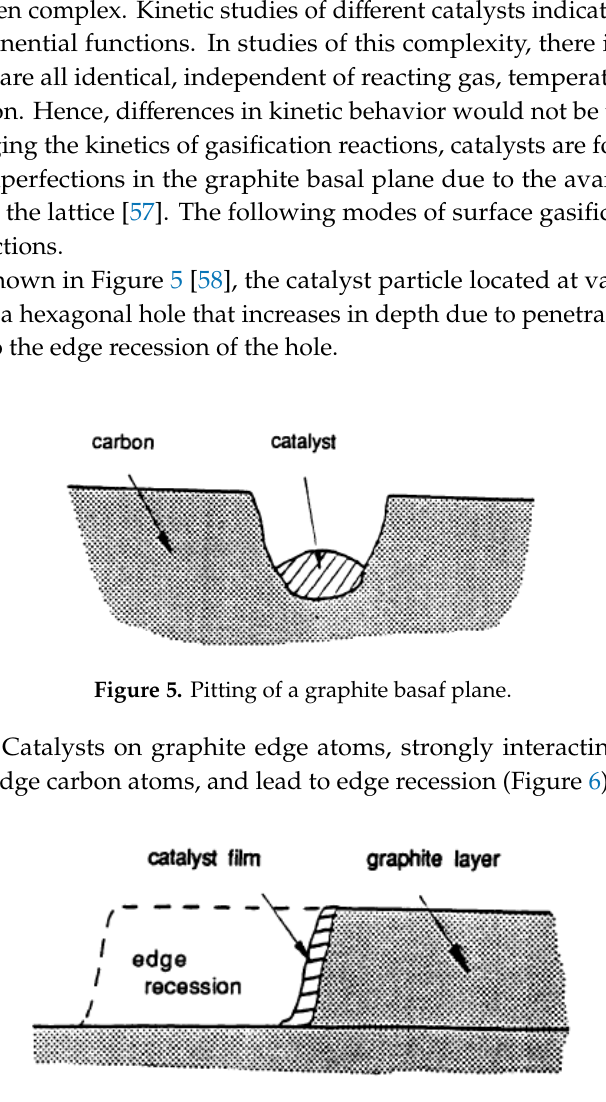
Figure 6. Catalytic edge recession of a graphite basal plane.